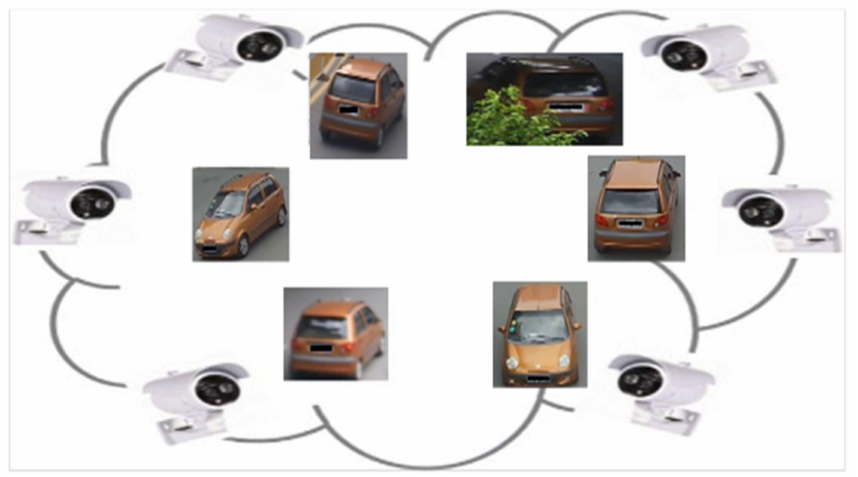
Figure 28. Images of the same vehicle taken from different cameras to illustrate the appearance